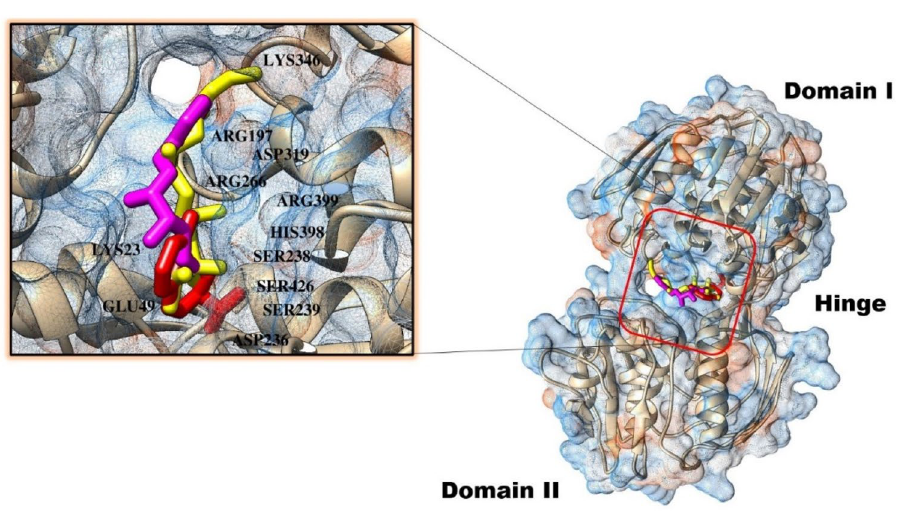
Figure 3. Intermolecular docked pose of the complexes. The enzyme is mesh surface and presented as cartoon. The compounds are colored in sticks. Top-1 (yellow), Top-2 (red) and Top-3